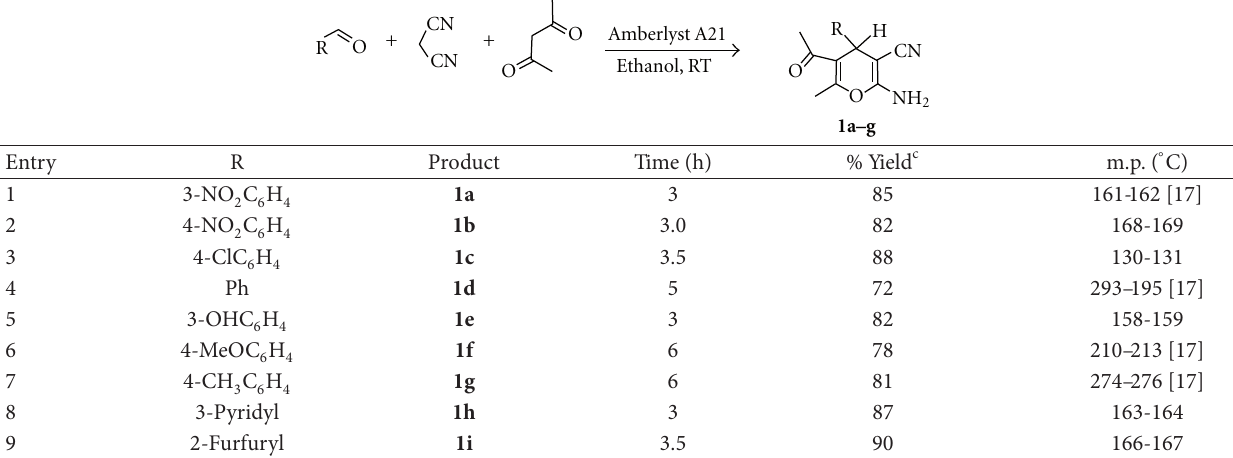
T 3: Synthesis of substituted pyrans from acetylacetone via Scheme 1. a,b